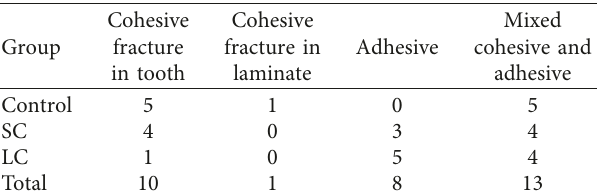
Table 2: Failure modes of broken